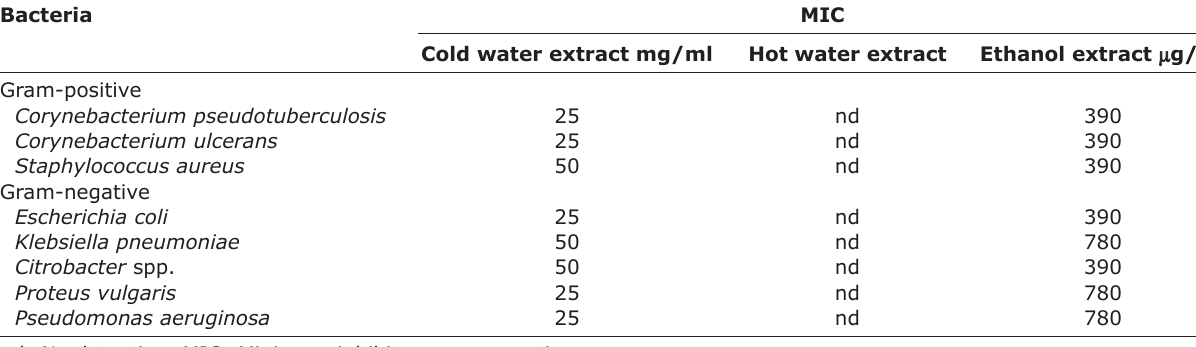
Table-3: MIC values of Moringa oleifera extract against some pyogenic bacteria.